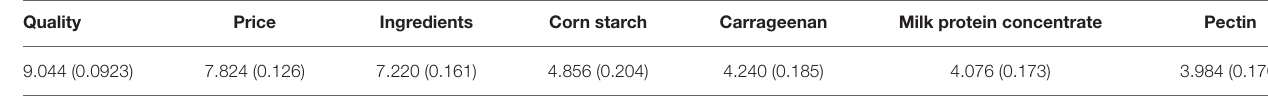
TABLE 2 | Mean ratings (SE) of agreement to attribute-related statements. Quality Price Ingredients Corn